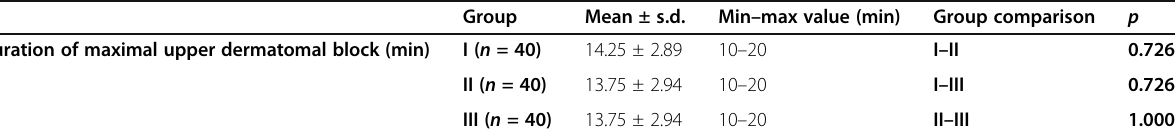
Table 5 Duration of the maximal upper dermatomal block (min) Group Mean ± s.d. Min – max value (min) Group comparison Duration of maximal upper dermatomal block (min)